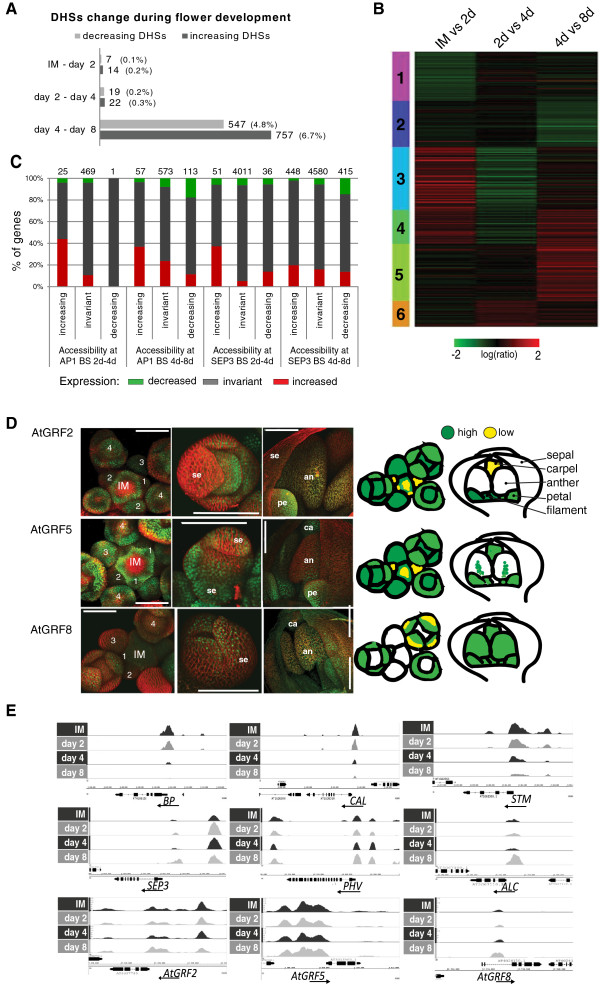
Dynamics of chromatin accessibility in Arabidopsis flower development. (A) Quantitative changes in DHSs between IM and day 2, 4, and 8 after flower induction for genomic regions detected as open chromatin at any time point and located nearby genes (3 kb upstream to 1 kb downstream of a gene). (B) K-means cluster analysis of differentially expressed genes. All the genes detected as differentially expressed (BH <0.05 and FC >1.8) in at least one time point comparison (IM vs. 2d, 2d vs. 4d, and 4d vs. 8d) are represented. (C) Percentage of genes in vicinity of AP1 or SEP3 and different classes of DHS, classified according to their expression change between days. Numbers above the bars show the total number of genes in the group. In all four cases there is a significant change of fractions across categories of DHS (χ2 test, P <0.001). (D) Confocal images of expression patterns of pGRF::GRF-GFP fusions in inflorescence meristems and during flower development. Expression patterns are summarized in schematic drawings on the right. Numbers indicate floral stage according to Smyth et al. [13], IM: inflorescence meristem, se: sepal, pe: petal, an: anther and ca: carpel. (E) Examples of TF gene loci that have DHSs with decreasing accessibility (top) and increasing accessibility (center) after flower induction. Genes involved in meristem identity like STM, BREVIPEDICELLUS (BP) and CAL show decreasing DHS peaks. On the other side, genes involved in flower organ initiation and determination like SEP3, PHV, and ALC show increased DHSs. In the bottom part of the figure are shown the accessibility profiles for AtGRF2, AtGRF5, and AtGRF8 loci are shown. DNase I hypersensitivity profiles at AtGRF2 and AtGRF5 loci do not change during time while an increase in accessibility is found for AtGRF8 locus between day 4 and 8.